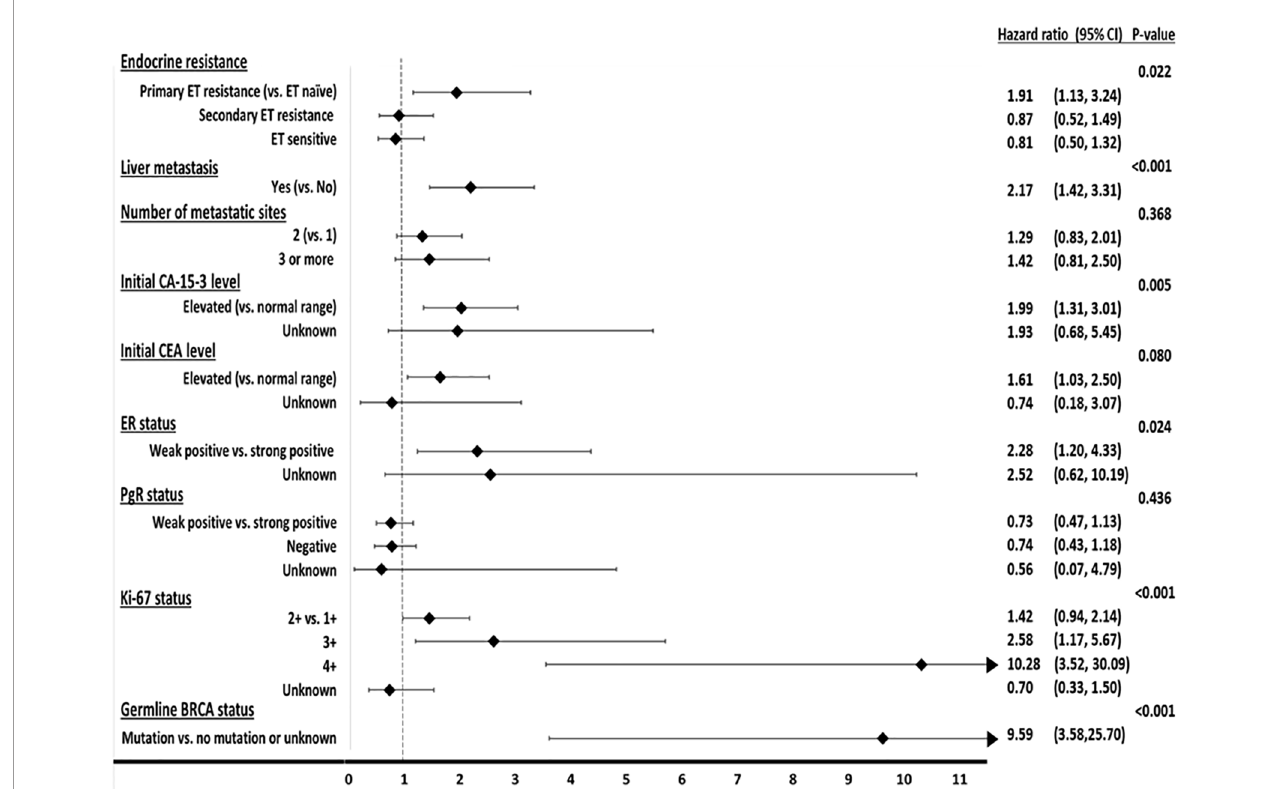
FIGURE 4 | Forest plot of multivariate analysis for factors affecting progression-free